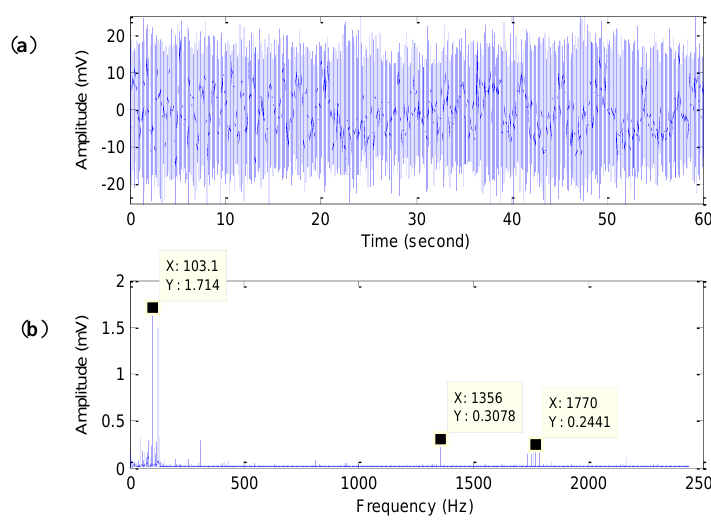
Figure 3. Slew bearing vibration signal on 30 August 2007: ( a ) 1 min duration signal; ( b ) FFT.